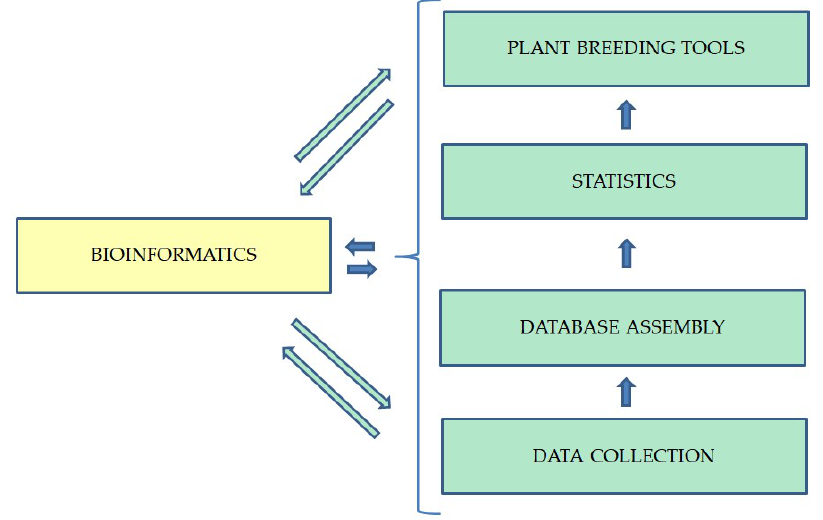
Figure 2. Operation process of bioinformatics in plant breeding.